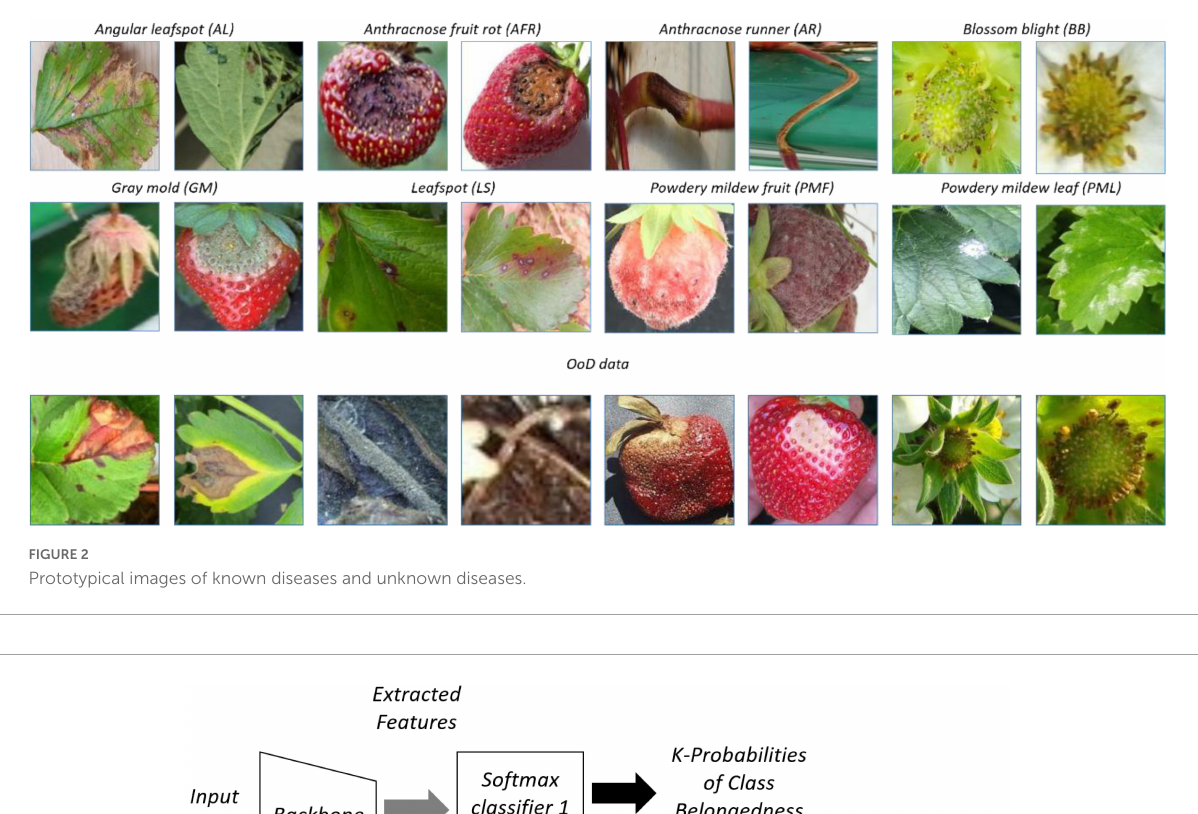
FIGURE3 Two-head network for Out-of-Distribution (OoD)